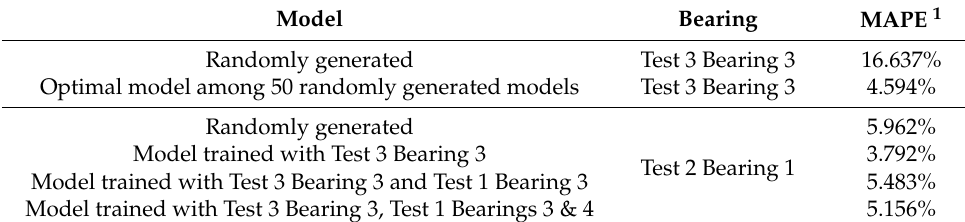
Table 3. Model training